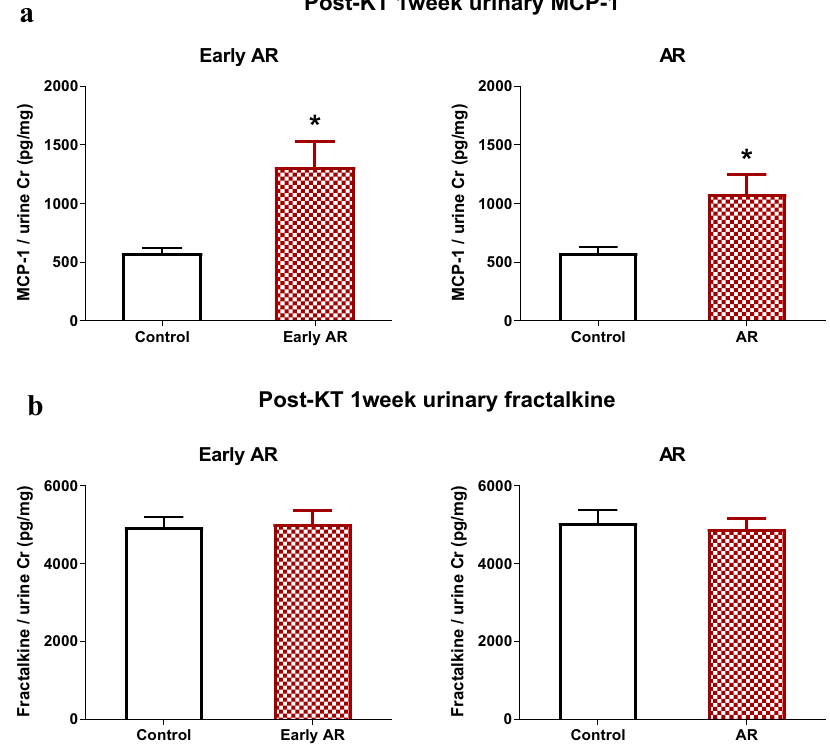
Figure 7. Post-KT 1 week urinary MCP-1 and fractalkine in a validation cohort. ( a ) In the validation cohort including 79 patients, both early AR and AR groups showed significantly higher urinary MCP-1 at 1 week after KT than the control group. ( b ) Post-KT 1 week urinary fractalkine was comparable in both control and AR groups. AR acute rejection, KT kidney transplantation, MCP-1 monocyte chemoattractant